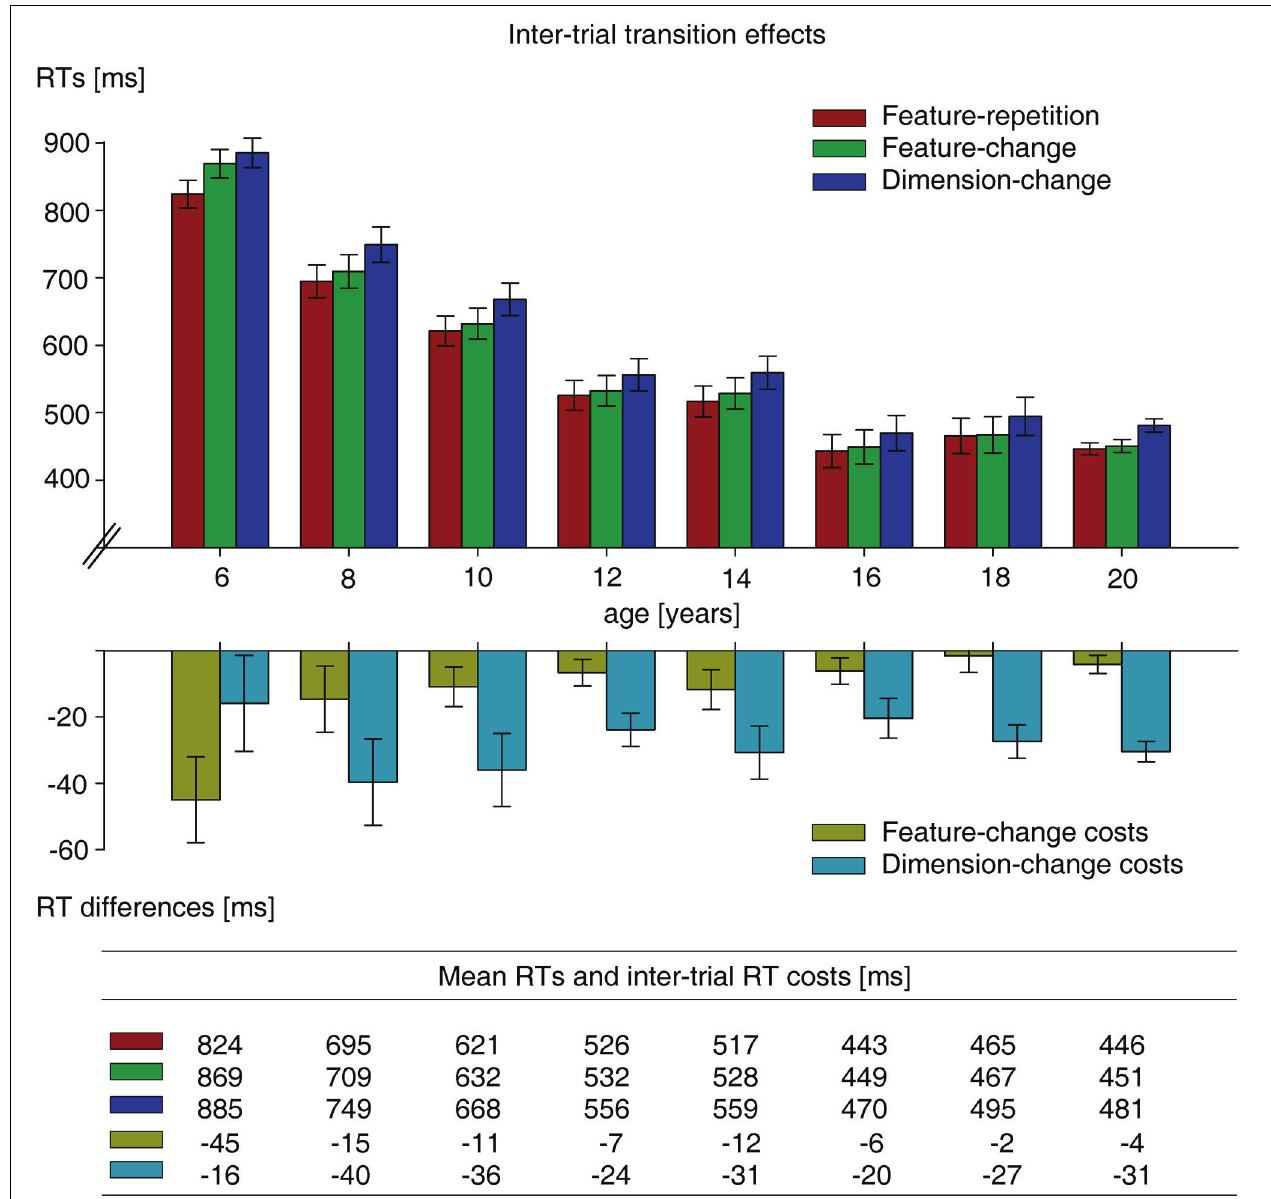
FIGURE 4 | Top panel: Mean search RTs on feature-repetition (e.g., red target [on trial N] preceded by a red target [on trial N-1]), feature-change (e.g., red target [trial N] preceded by a blue target [trial N-1]), and dimension-change (e.g., red target [trial N] preceded by a left-tilted target [trial N-1]) trials, separately for each age group. Bottom panel: Relative